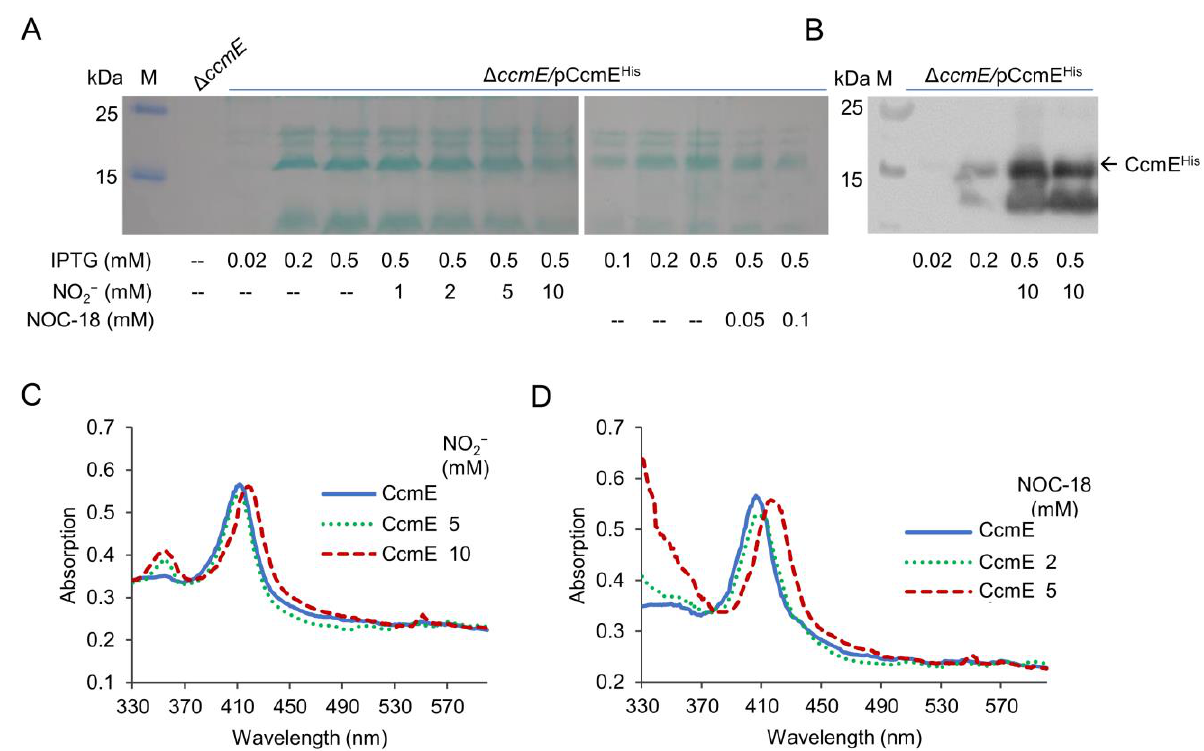
Figure 6. Impacts of nitrite/NO on CcmE. ( A , B ) Impacts of nitrite/NO on CcmE in vivo. Δ ccmE cells producing His-tagged CcmE with IPTG at varying concentrations were grown to the early stationary phase without or with indicated nitrogen oxides. Proteins with heme covalently attached were examined by heme staining ( A ) and by Western blotting ( B ). ( C , D ) UV –visible spectra of 2 μM CcmE solutions. Shown are untreated and treated with nitrite ( C ) or NOC-18 ( D ) at indicated concentrations for 5 h. Experiments were performed three times, and representatives are presented.